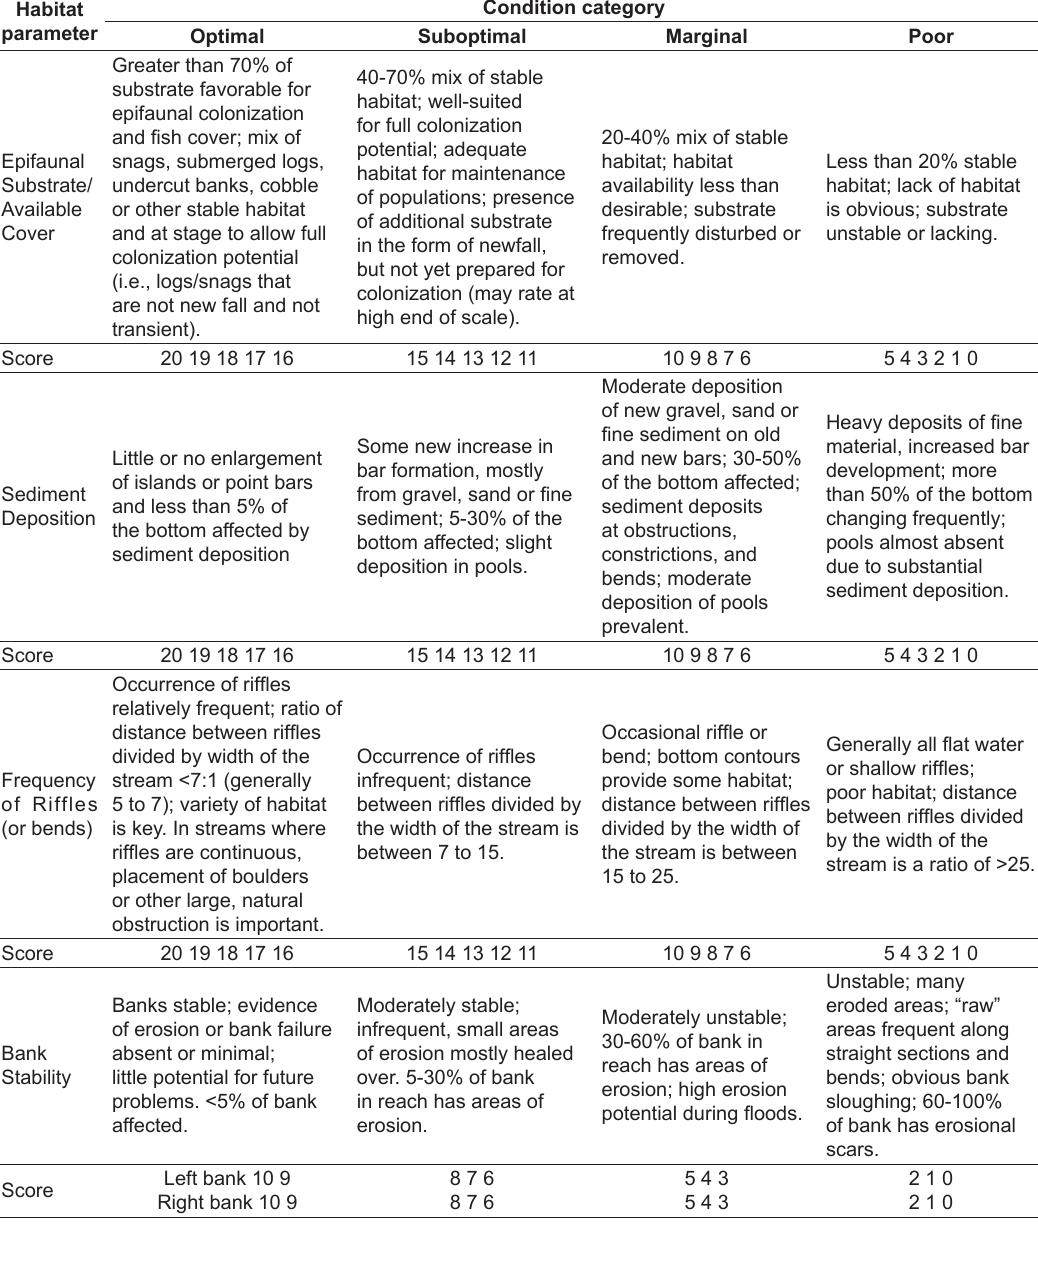
Table 1. Habitat parameters, condition categories and scores of the sampled streams from Atlantic Forest of south São Paulo State (adapted from Barbour et al., 1999). Condition category Habitat parameter Optimal Suboptimal Marginal Poor